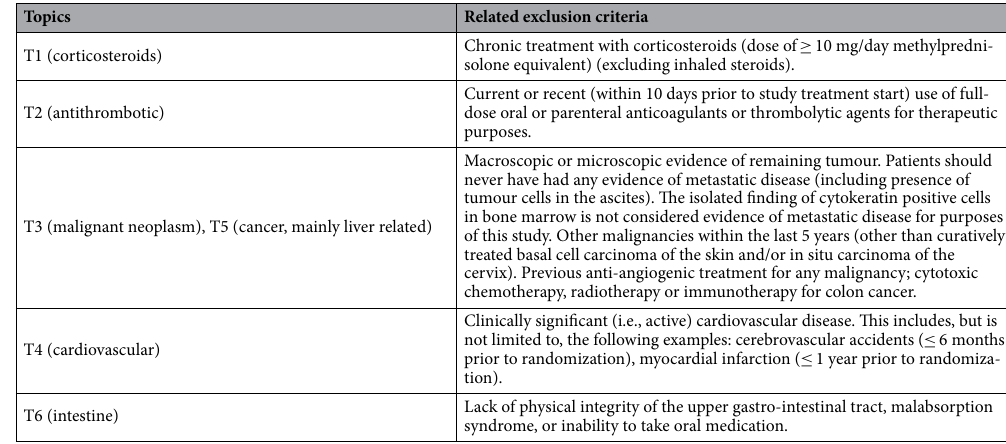
Table 4. Inferred topics and related exclusion criteria in the original bevacizumab trial (i.e.,